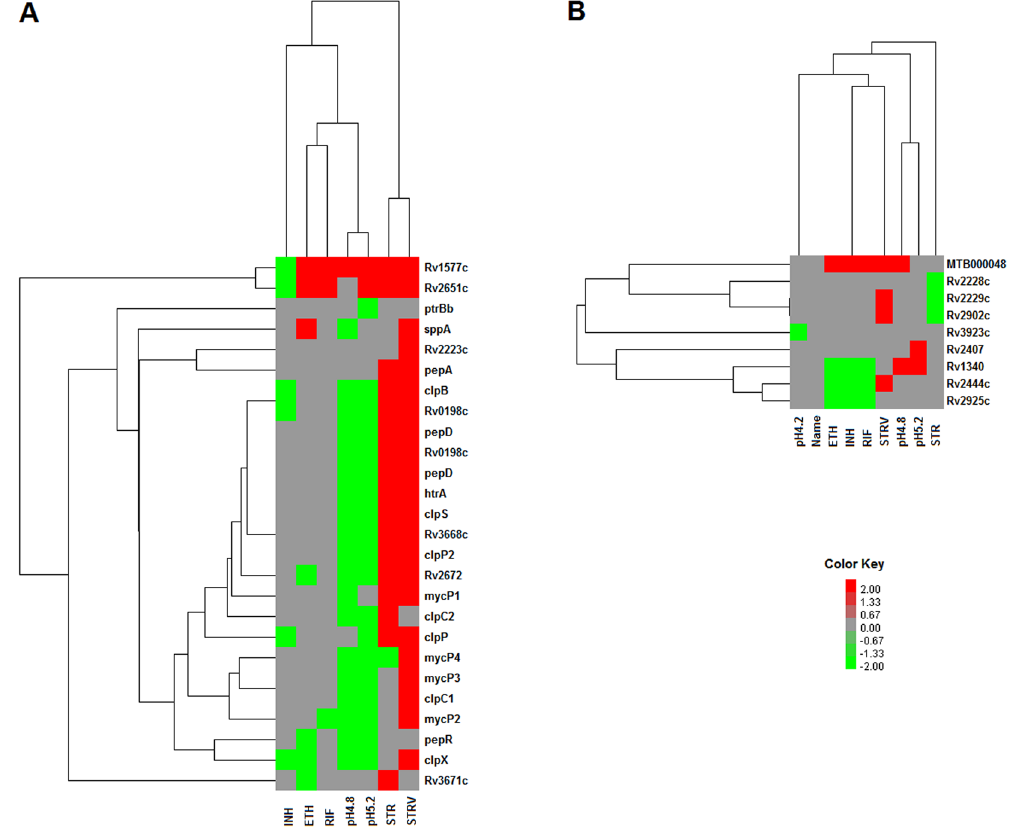
Figure 8. ( A ) Unsupervised hierarchical clustering analysis of protease genes based on their activation and deactivation status in response to stress. ( B ) Unsupervised hierarchical clustering analysis of nuclease genes based on their activation and deactivation status in response to stress Fold change of genes in late time point was subtracted from early time point to calculate the activation deactivation score. The cluster was created as described for Figs 5 and